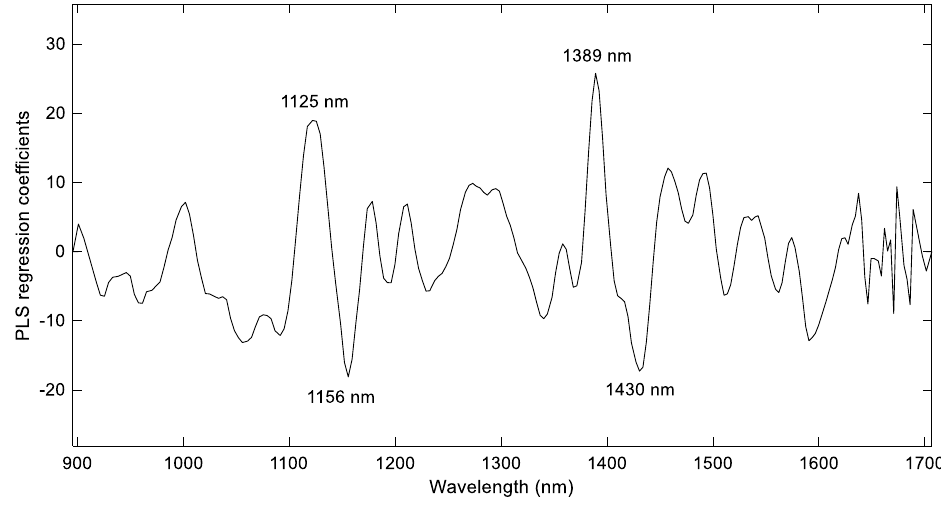
Fig. 7. Regression coe±cients of NIR-based PLSR